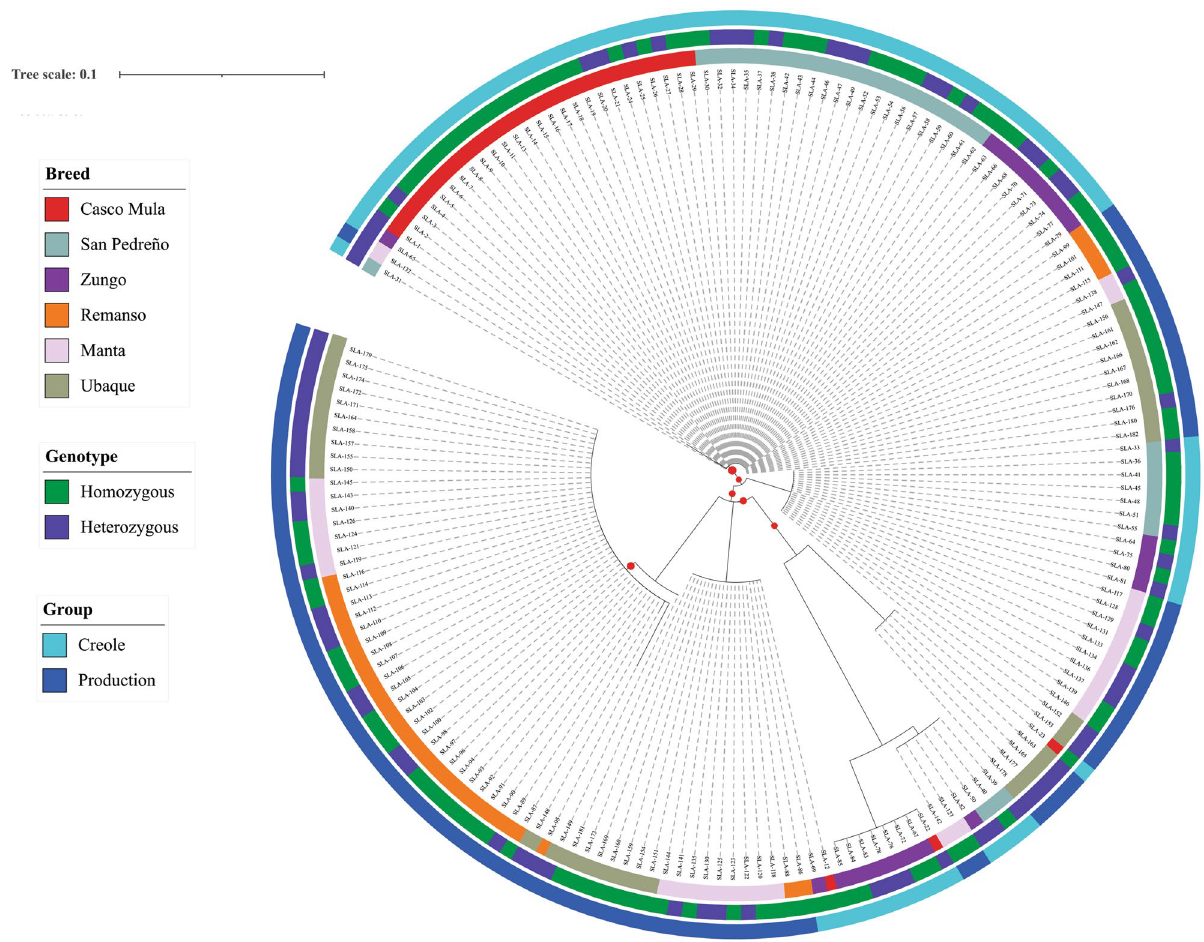
Figure 3. Homozygosity and heterozygosity distribution according to the populations analysed here.